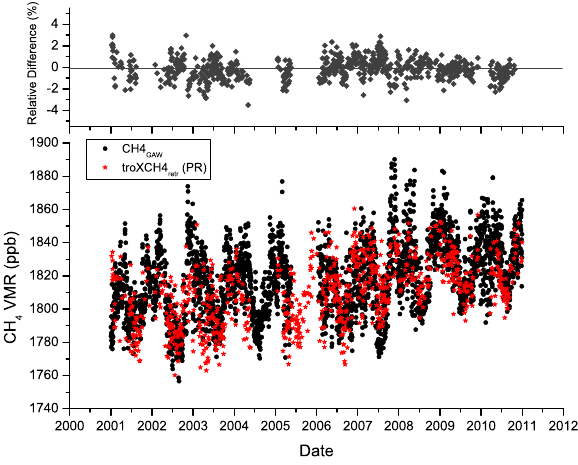
Fig. 9. Same as Fig. 5, but for the directly retrieved tropospheric XCH 4 (troXCH 4 , red stars) from the profile retrieval. retr